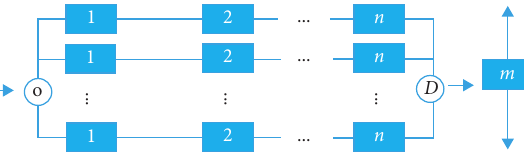
Figure 4: Schematic diagram of the parallel-series system.